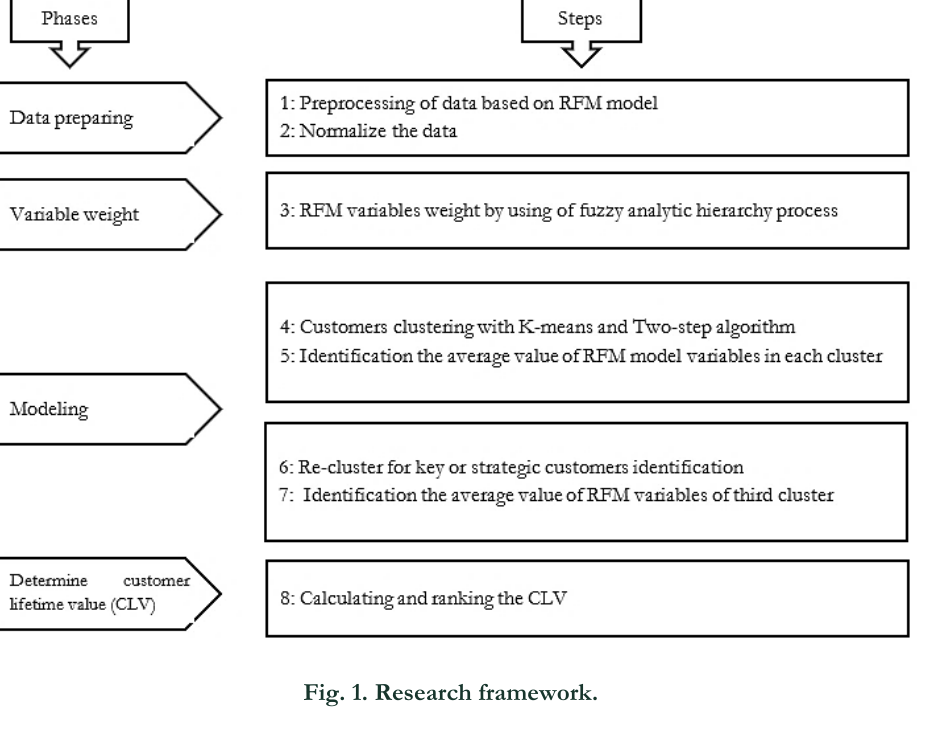
Fig. 1. Research framework.